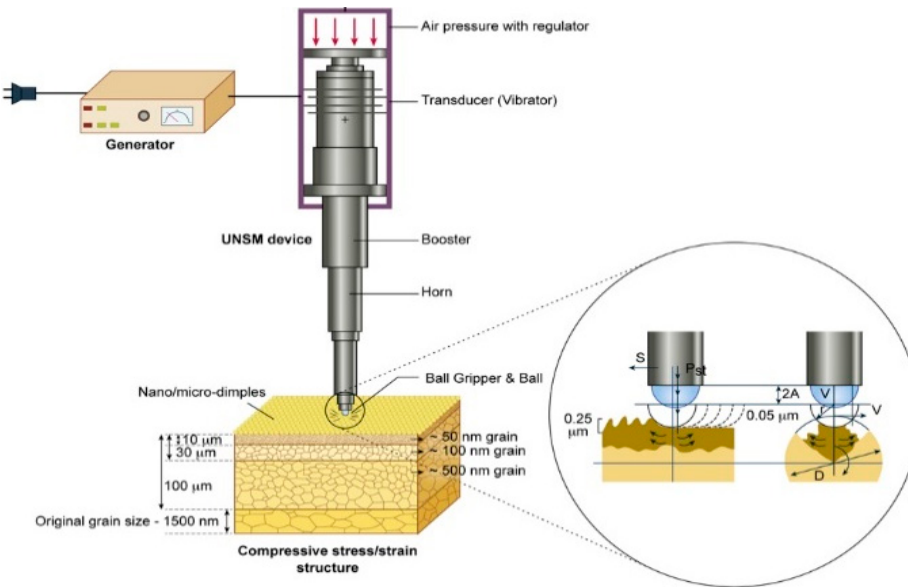
Figure 1. Cross-sectional SEM image showing the thickness of the carburizing layer on heat-re- sistant KHR 45A steel substrate.